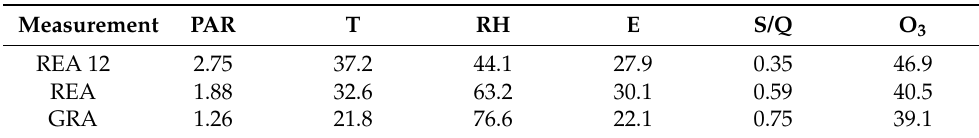
Table 4. Averages of the parameters measured in the establishment of the BVOC empirical model, by all REA and all gradient